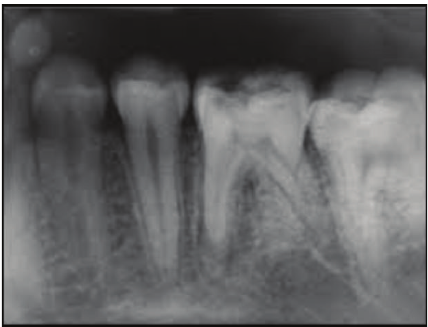
Figure 2: Preoperative IOPA of